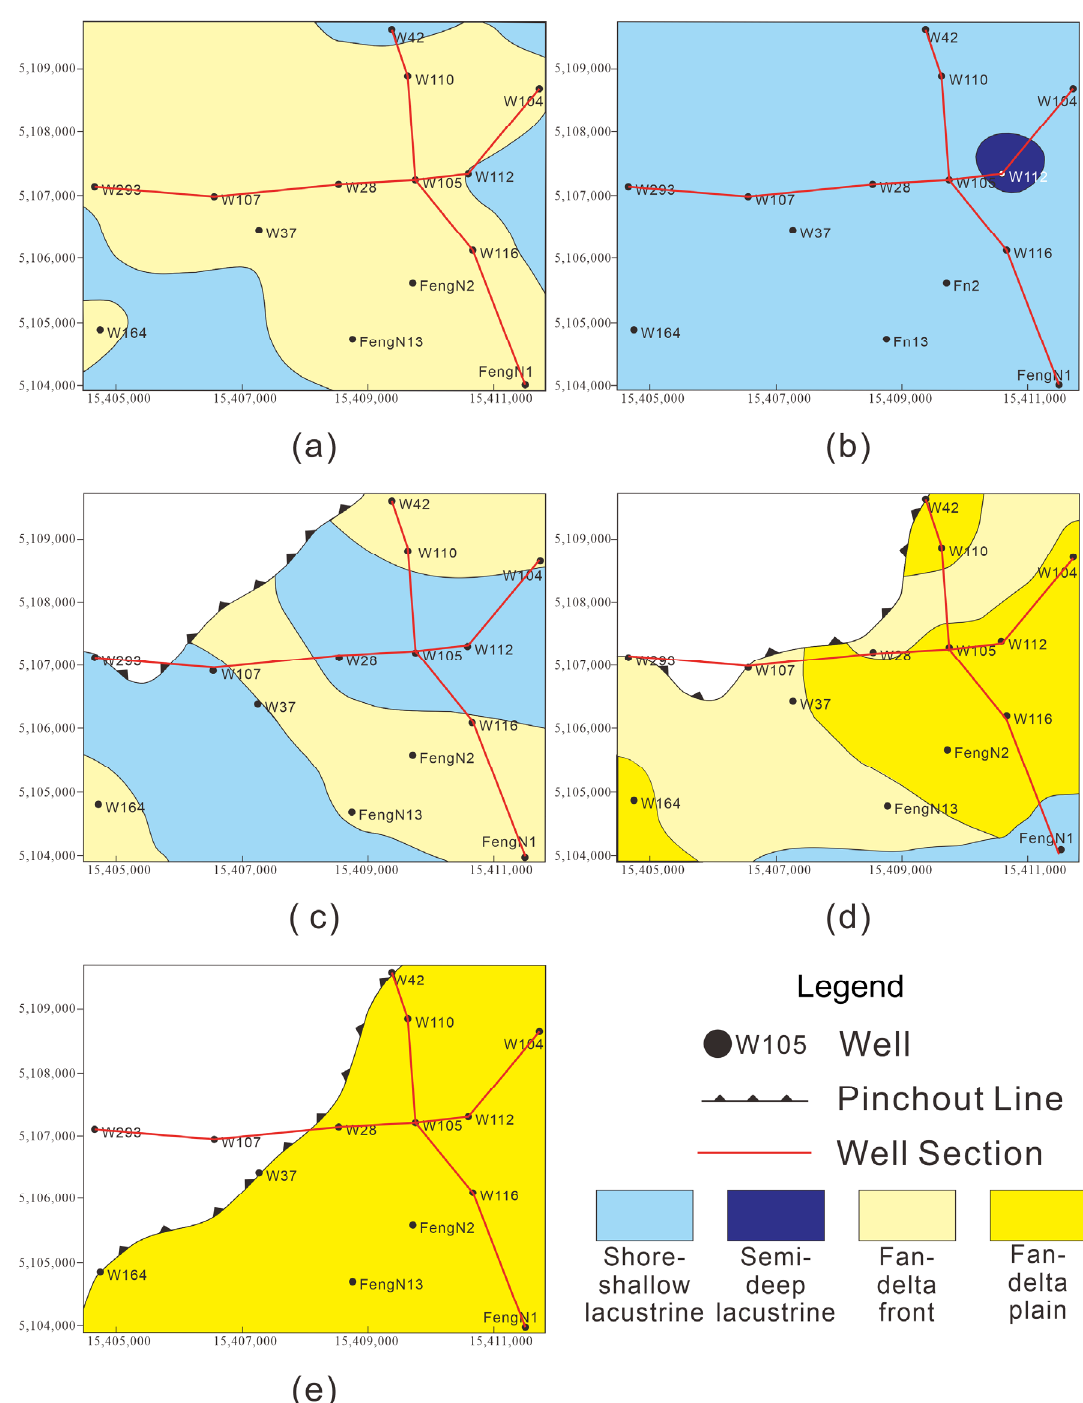
Figure 11. Planar view of the sedimentary facies of Jurassic strata in the study area: ( a ) Badaowan Formation; ( b ) Sangonghe Formation; ( c ) Xishanyao Formation; ( d ) Toutunhe Formation; ( e ) Qigu Formation.